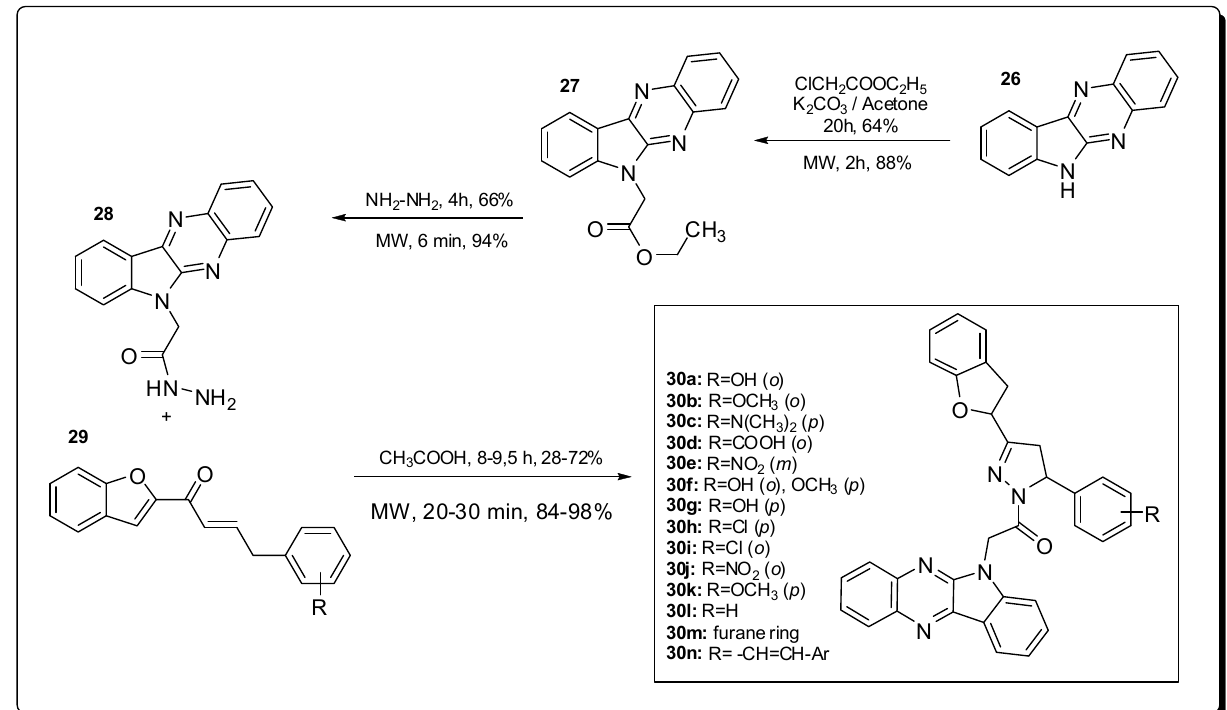
Figure 9. Synthesis of pyrazoline derivatives 30a – n